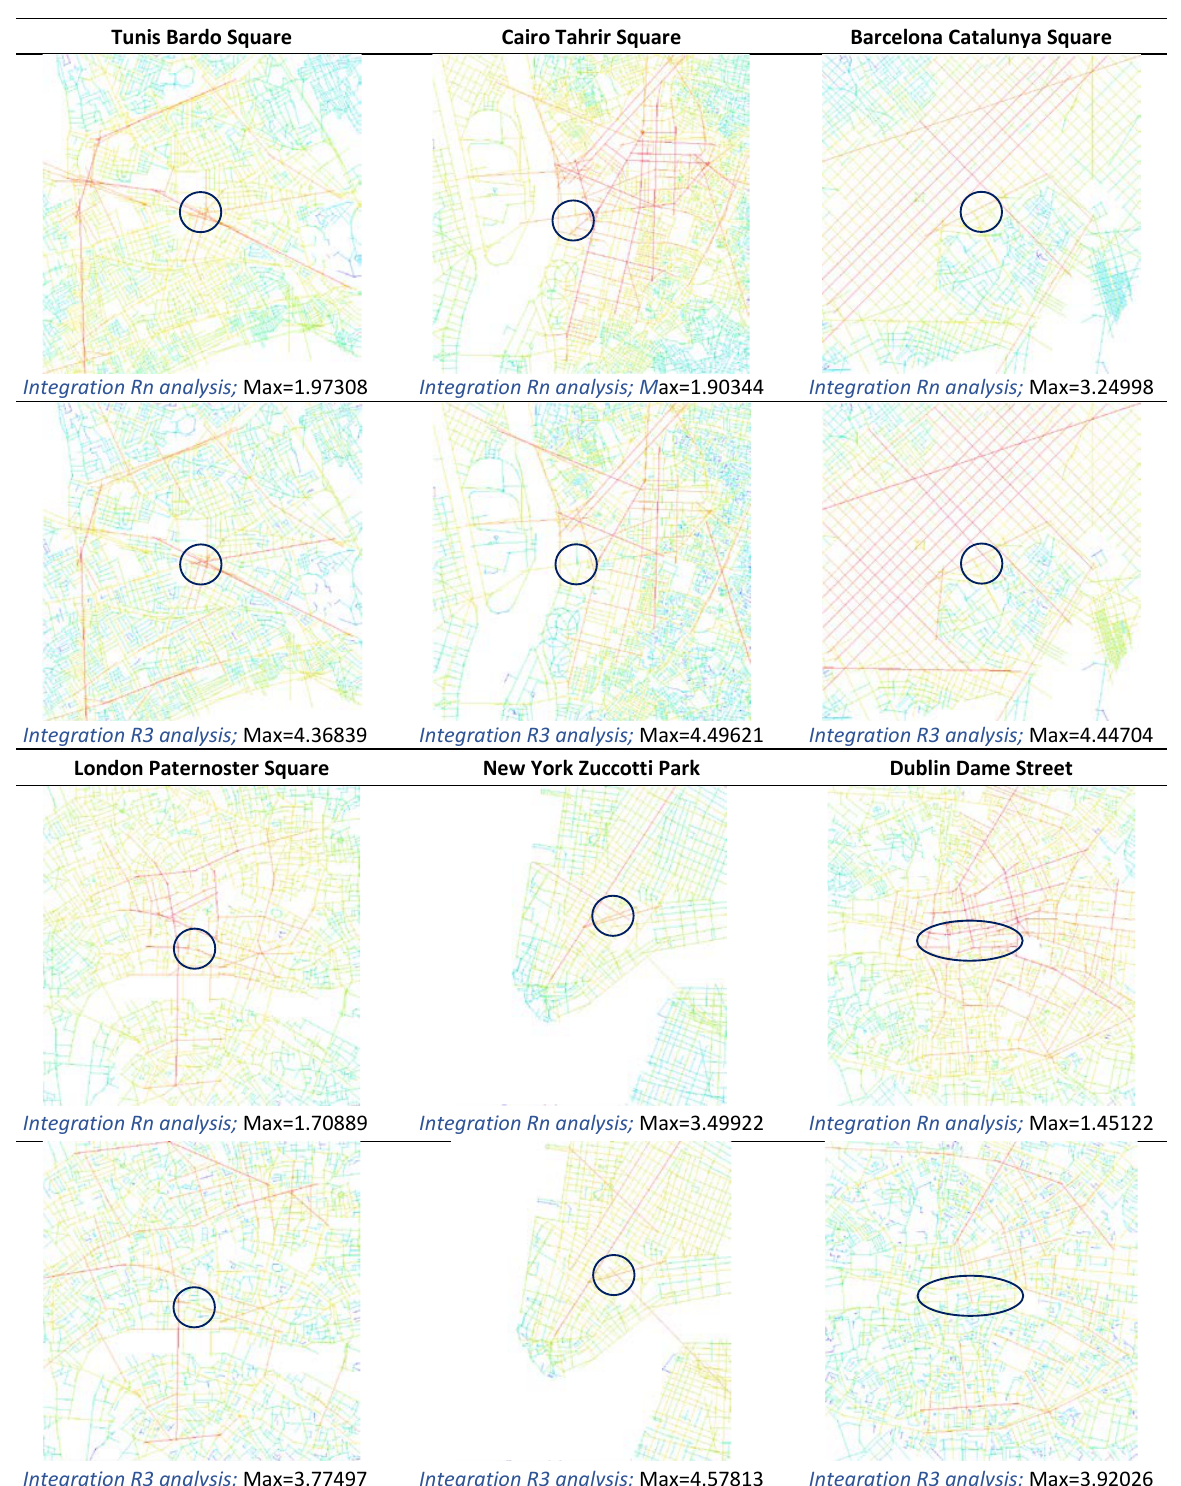
Table 1 Results of the space syntax analyses of rebel